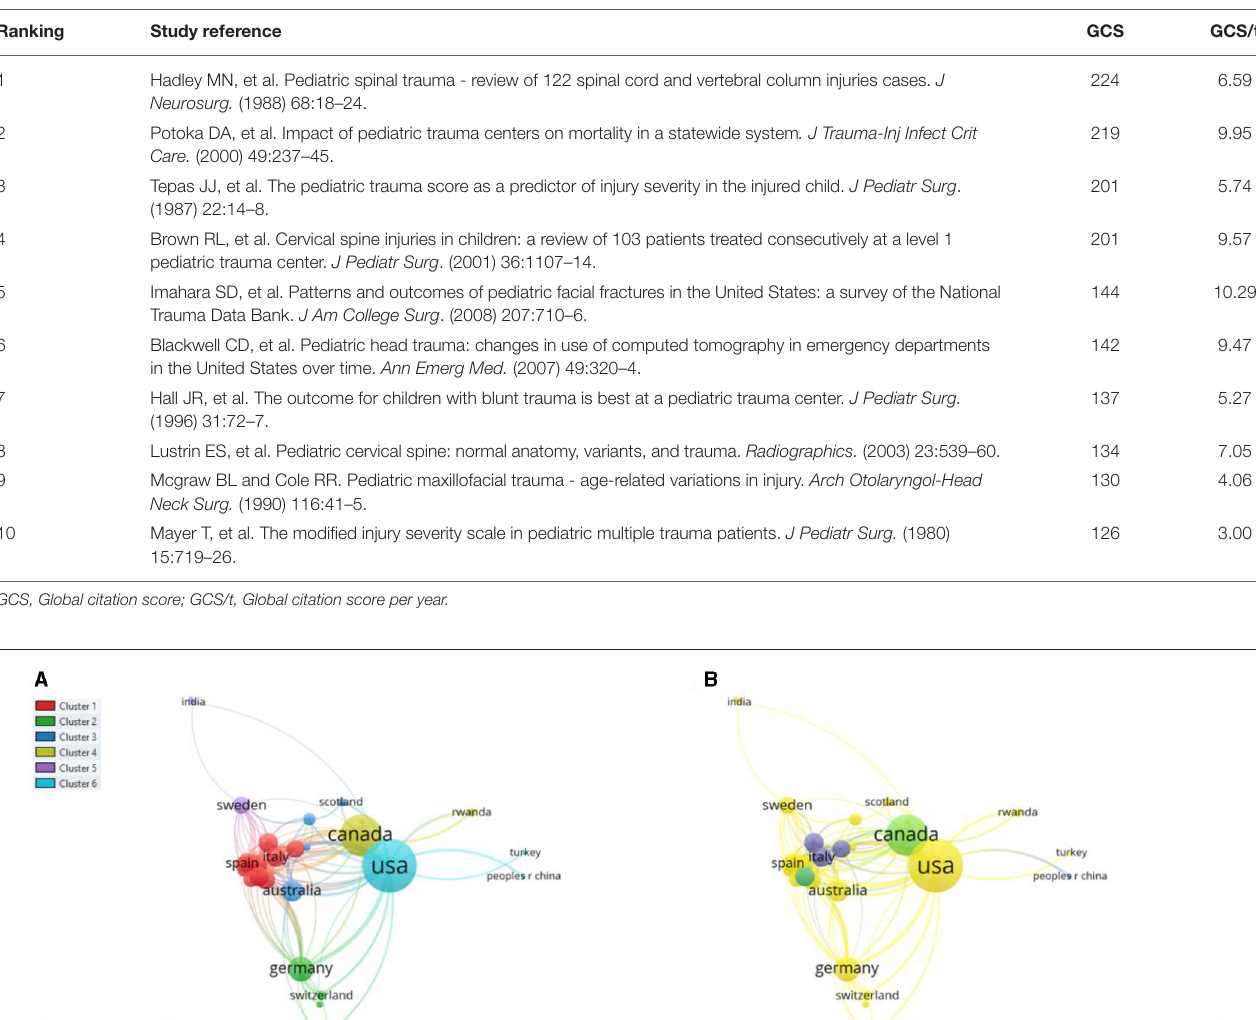
TABLE 1 | Top 10 most cited publications in pediatric trauma research.